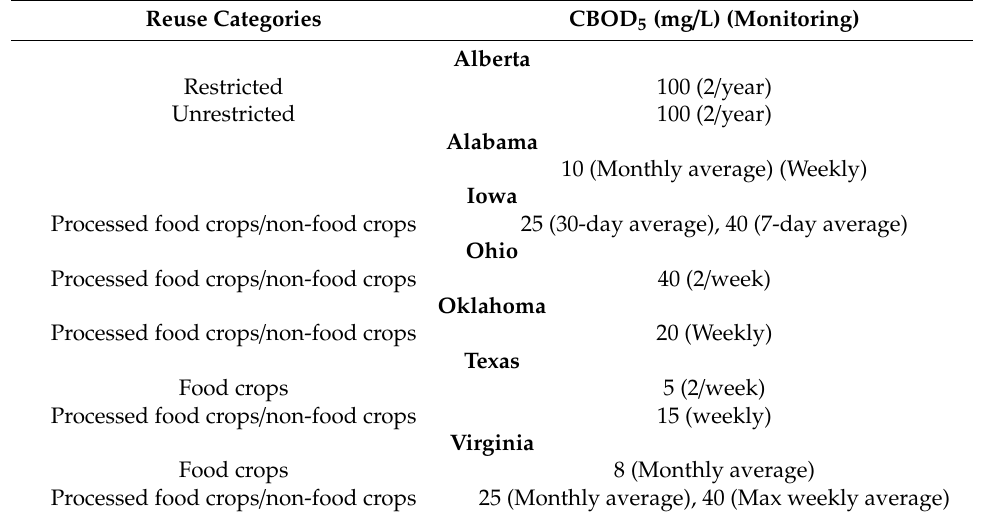
Table 17. CBOD 5 thresholds in agricultural water reuse regulations and guidelines.